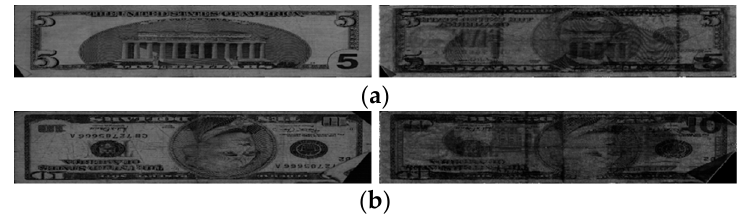
Figure 8. Examples of KRW banknote images: ( a ) fit; ( b ) normal; and ( c ) unfit banknotes. Images in each figure have the same order as those in Figure 7.